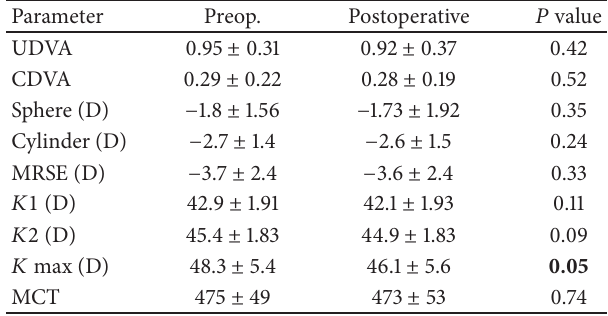
Table 2: Pre- and postoperative measured parameters (mean ± SD) ofthestudiedpatientsinsequentialgroup6monthsafterCXLalone.